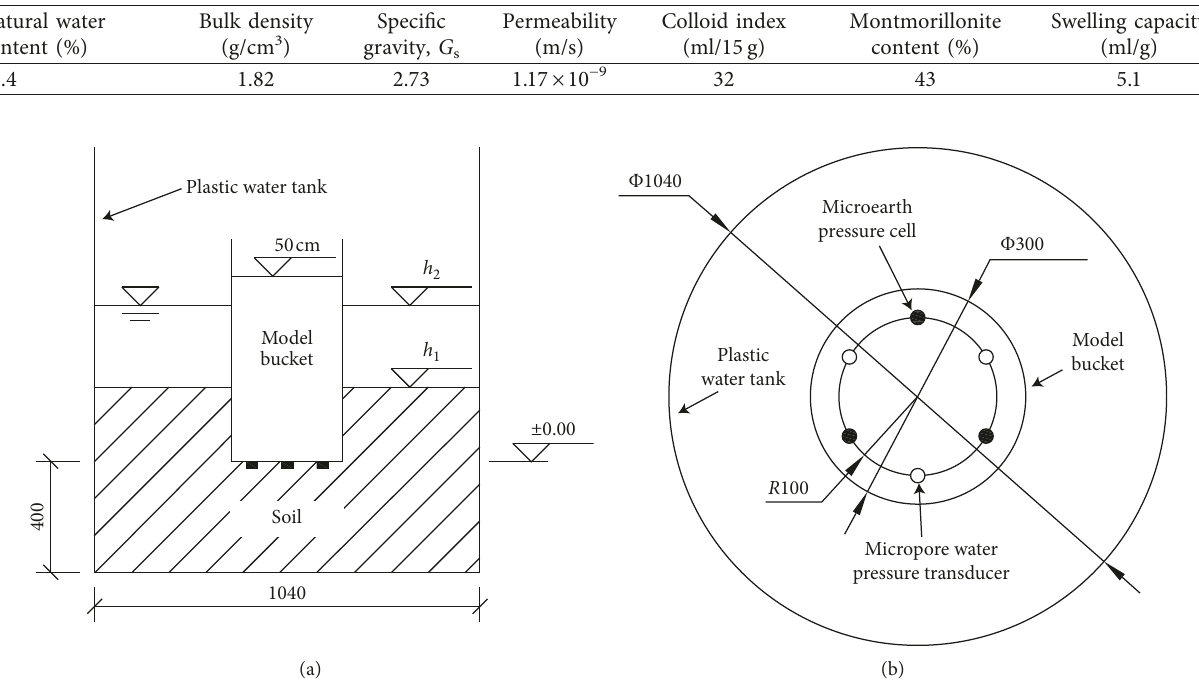
Figure 2: Schematic diagram of the test setup. (a) Front view (mm). (b) Plan view (mm).